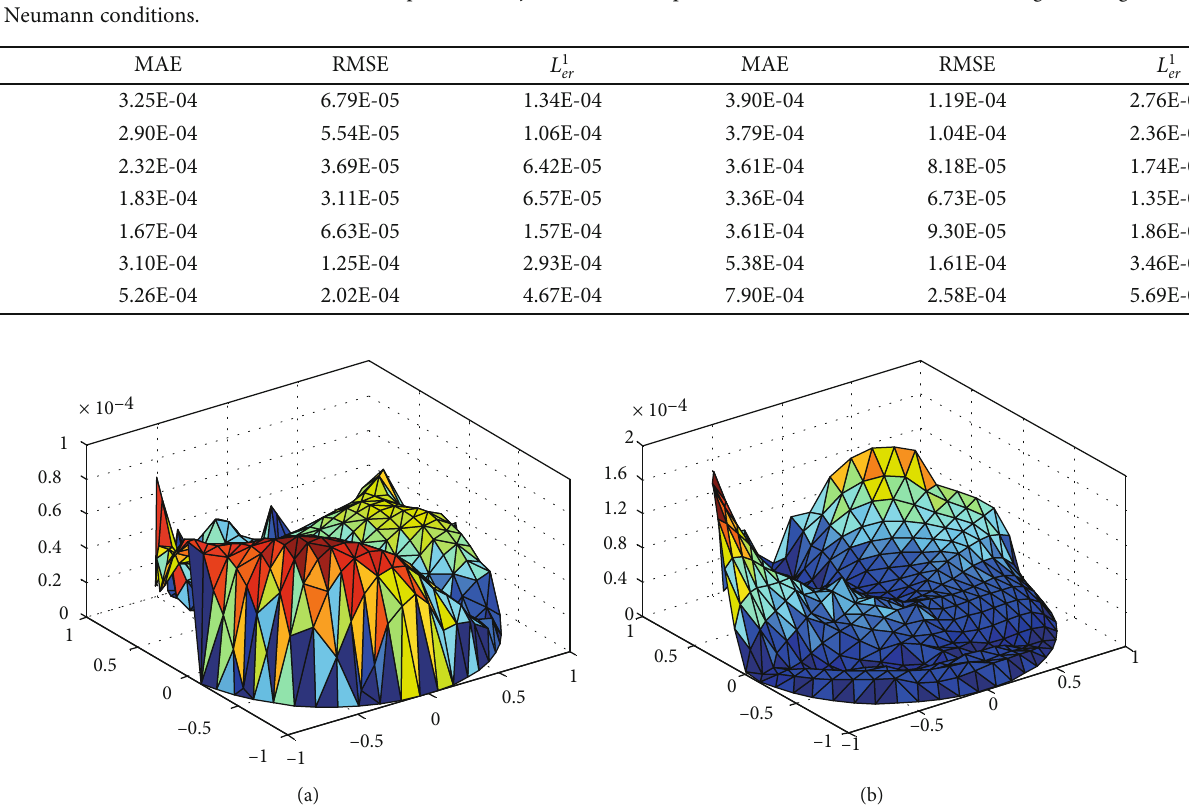
= 20 . Uniform spaced nodes (left) and circular nodes (right), using Dirichlet t